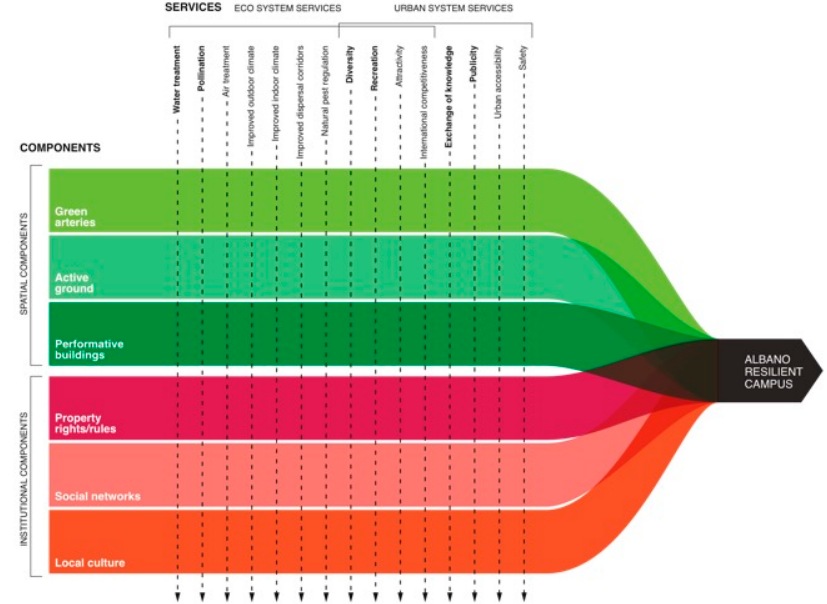
Figure 3. The SEU-approach is striving toward a closer braiding of social and ecological services in the design of cities. This entails that institutional components, such as property-rights and culture- specific social norms, are treated at par with ecological design components to simultaneously promote social and ecological services at the micro ‑ scale of cities. Source: Barthel et al. [1].